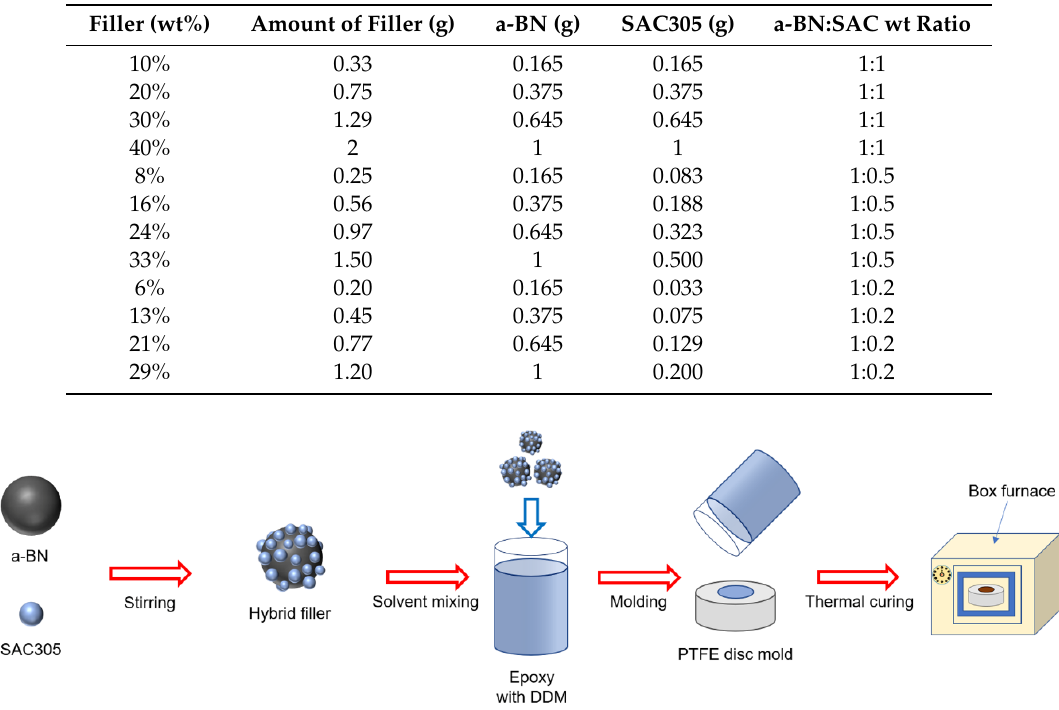
Table 1. Experimental condition for preparation of composites with various ratios of the hybrid fillers. Filler (wt%) Amount of Filler (g) a-BN (g) SAC305 (g) a-BN:SAC wt ratio 10% 0.33 0.165 0.165 1:1 20% 0.75 0.375 0.375 1:1 30% 1.29 0.645 0.645 1:1 40% 1:1 8% 0.25 1:0.5 16% 0.56 0.375 0.188 1:0.5 24% 0.97 0.645 0.323 1:0.5 33% 1.50 0.500 1:0.5